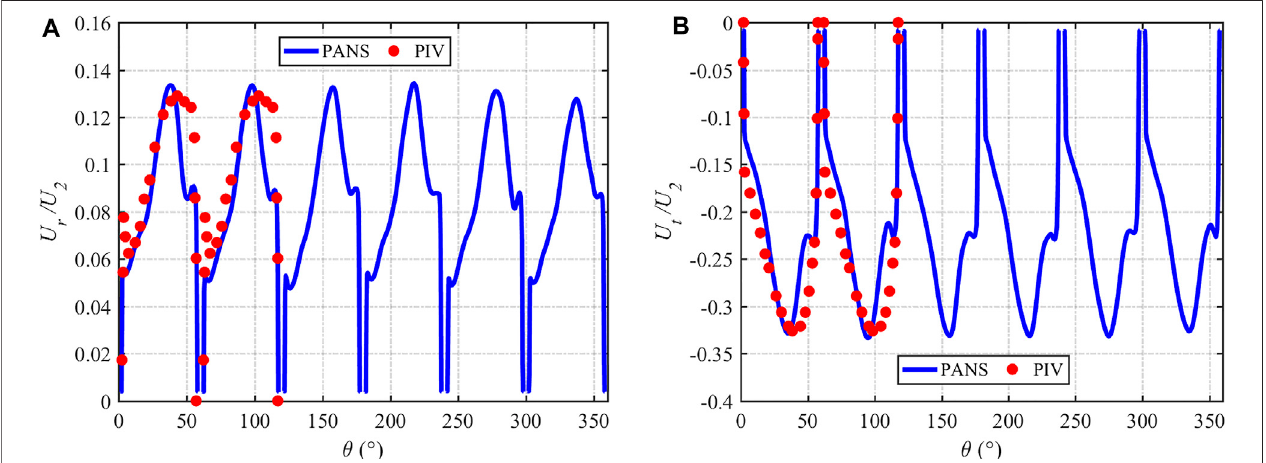
FIGURE 13 | Comparison of time-averaged velocity at Q = 1.0 Q 0 fl ow condition: (A) 0.75 R 2 radial velocity and (B) 0.75 R 2 tangential velocity.